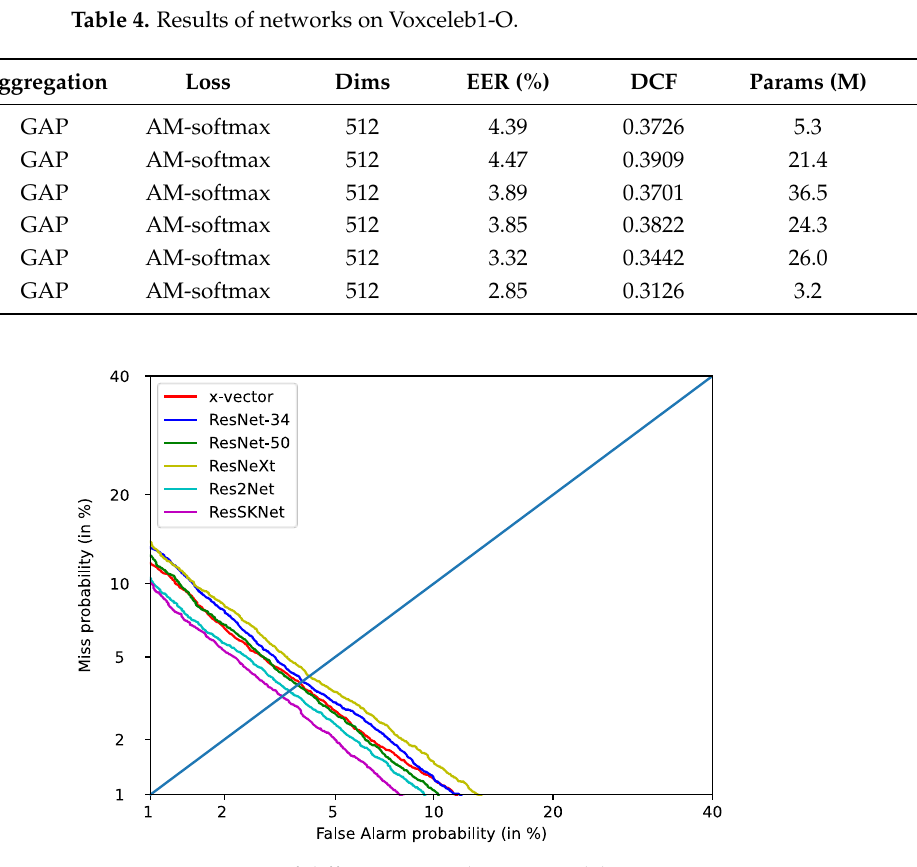
Figure 3. DET curve of different networks on Voxceleb1-O. Table 4. Results of networks on Voxceleb1-O.